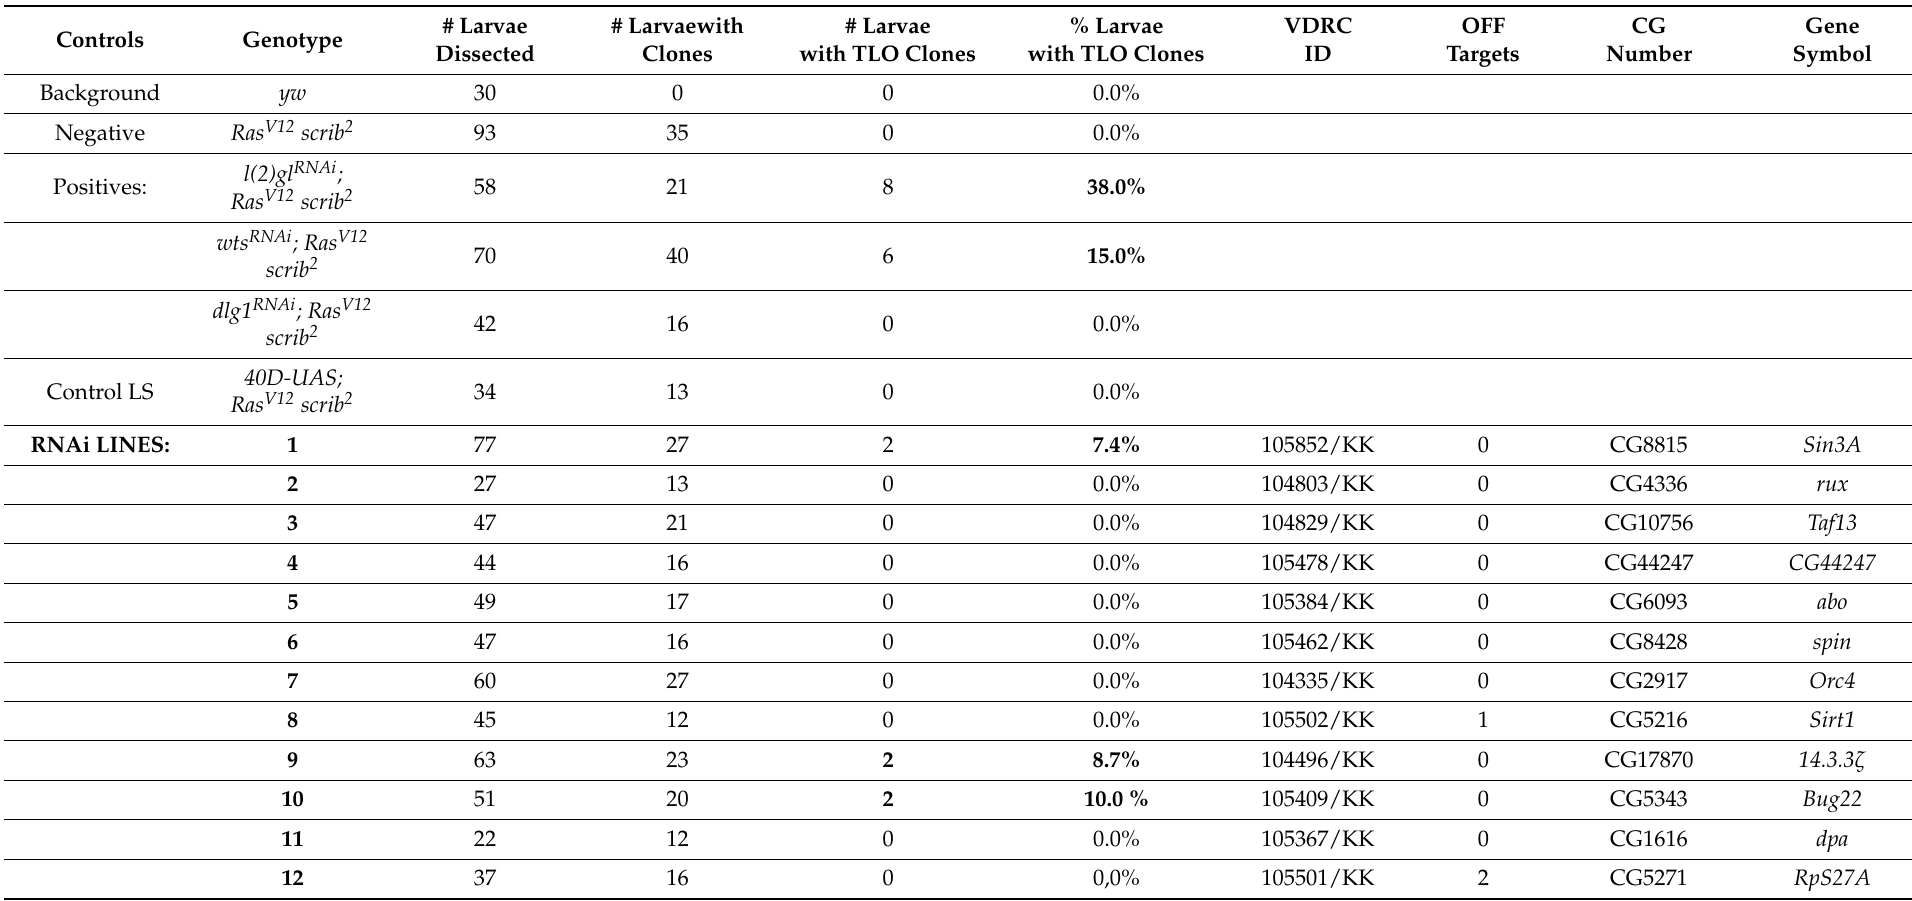
Table 1. Control and UAS-RNAi lines were analyzed on the screen. Background, negative and positive controls were run (see Figure 3 for detailed genotypes). dlg1 RNAi ; Ras V 12 scrib 2 larval brains did not show clear cases of TLO in the larvae analyzed (see also text). An additional control for the KK library landing site (LS) at 40D, without any RNAi line, was carried out, as the UAS-wts RNAi line was inserted at that location. Fifteen potential positive lines (highlighted in green), i.e., those that showed TLO following the established criteria (see text for details), were selected out of 79 UAS-RNAi lines screened, which finally corresponded with 77 different genes (as lines 47 and 48 represent the same gene, as well as lines 61 and 75). Lines 28, 37, 38, 49, and 50 are currently discarded in